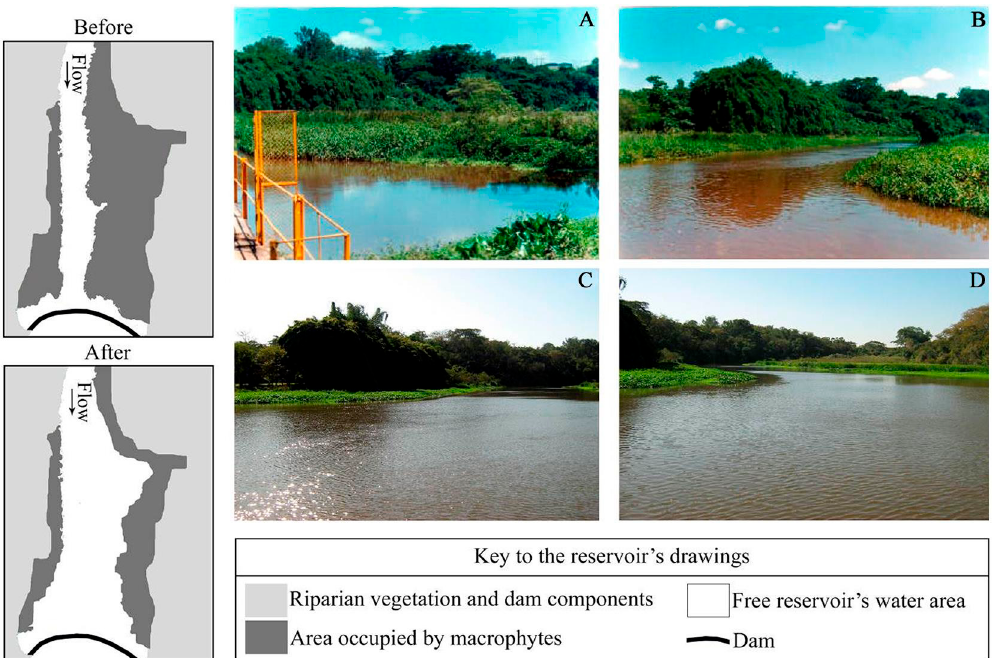
Figure 2. Gavião Peixoto Reservoir before (A and B; 2005) and after (C and D; 2008) the dredging and management of